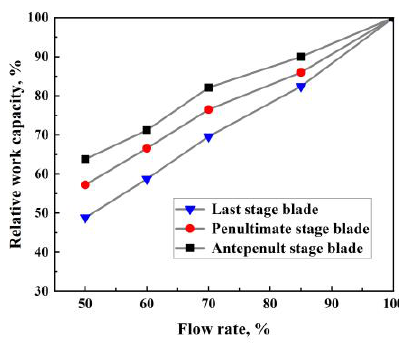
Figure 15. Amount of work performed by the last three stage blades (1.9 MPa back pressure) .